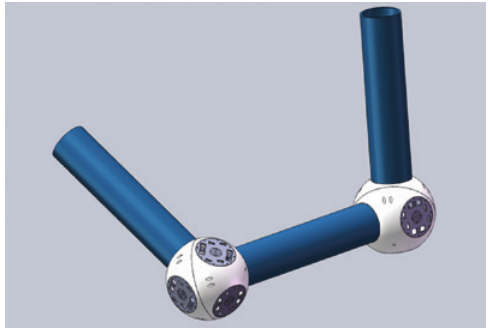
Figure 1: Schematic diagram of module for VCS.